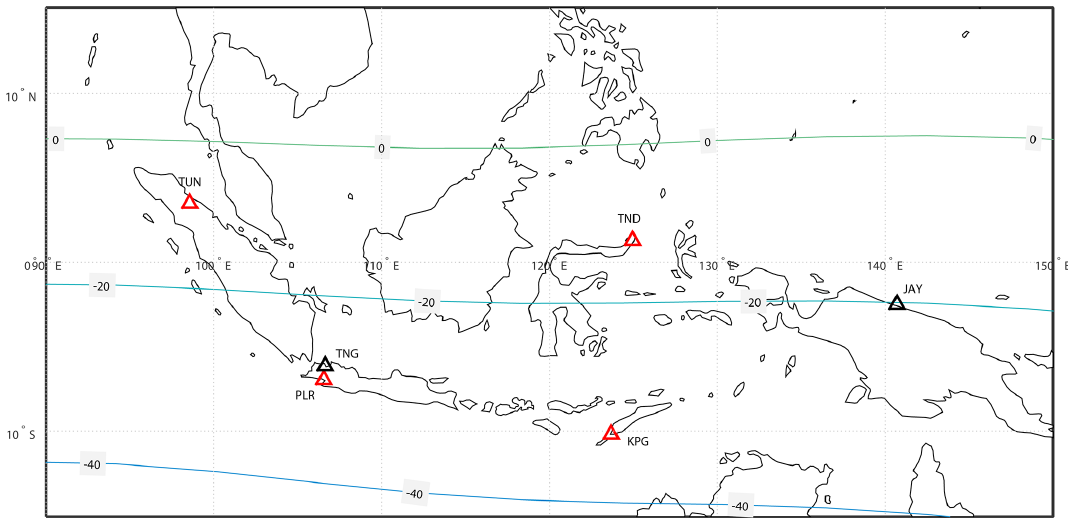
Figure 1. Indonesian geomagnetic observatory map. The red triangles are observatories from which data are used in this paper. The black triangles are observatories from which data are not used in this paper. The IAGA codes are depicted by the three-letter names of each observatory (JAY is still a provisional code). The contours are of the inclination of magnetic field in degrees from the 2015 WMM (World Magnetic Model) (Chulliat et al.,